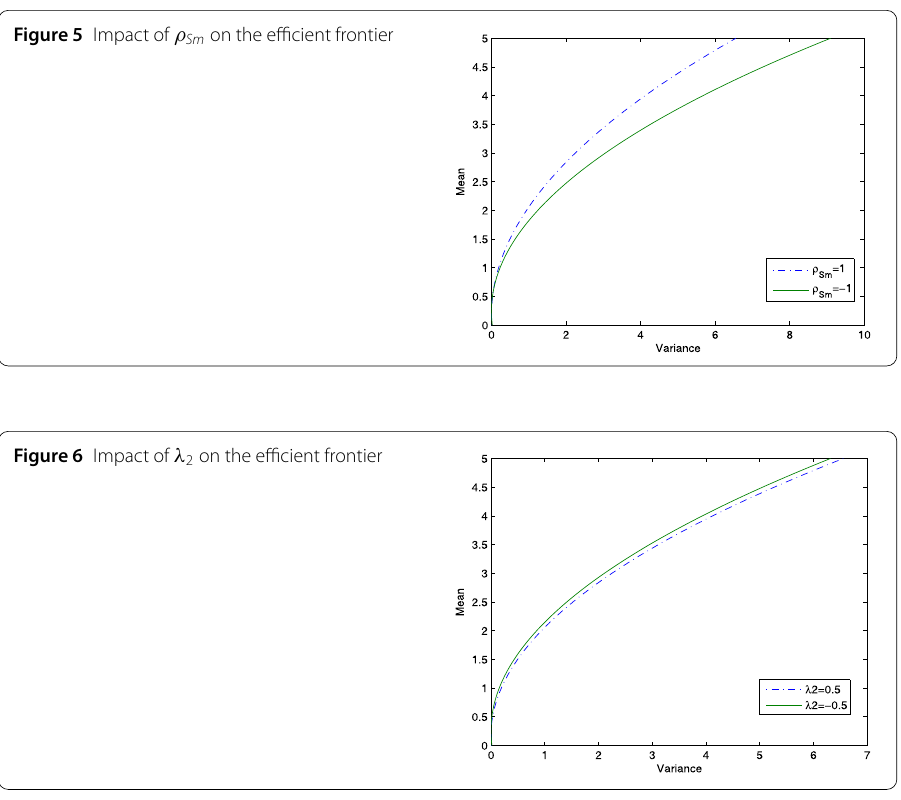
Figure 5 Impact of ρ Sm on the efficient frontier